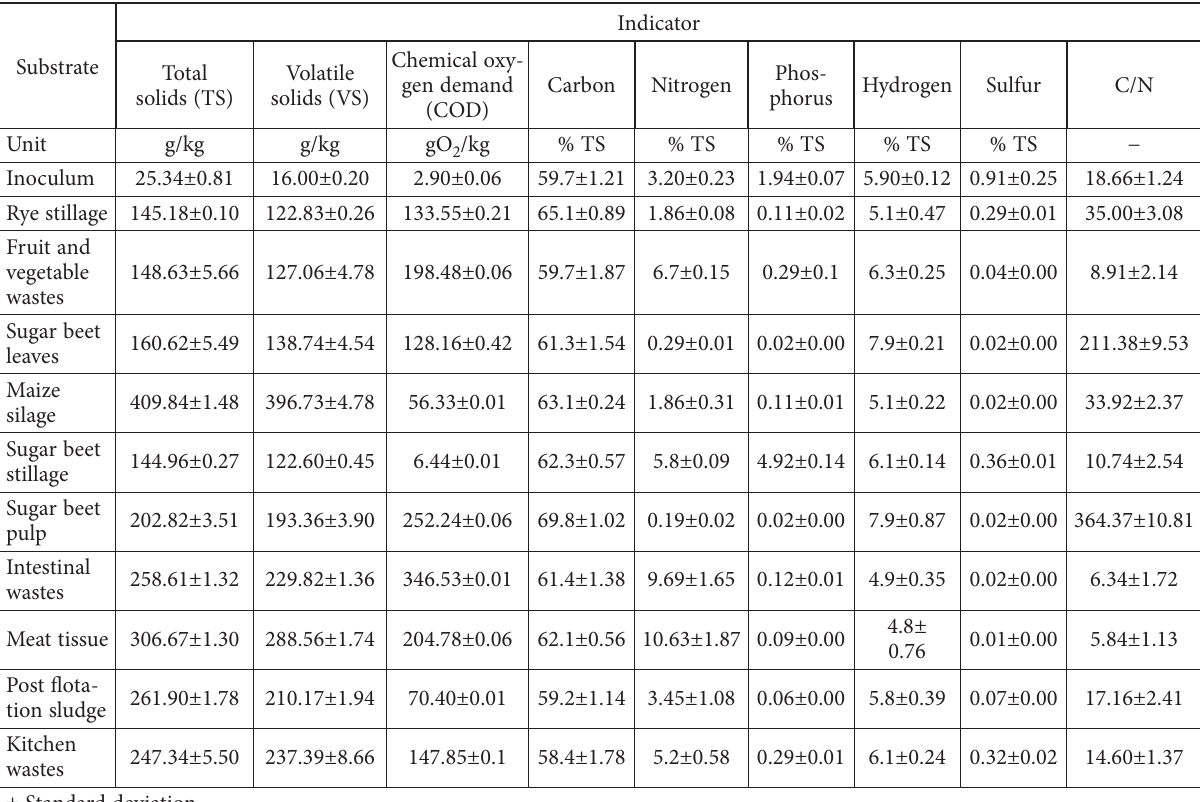
Table 1. Characteristics of